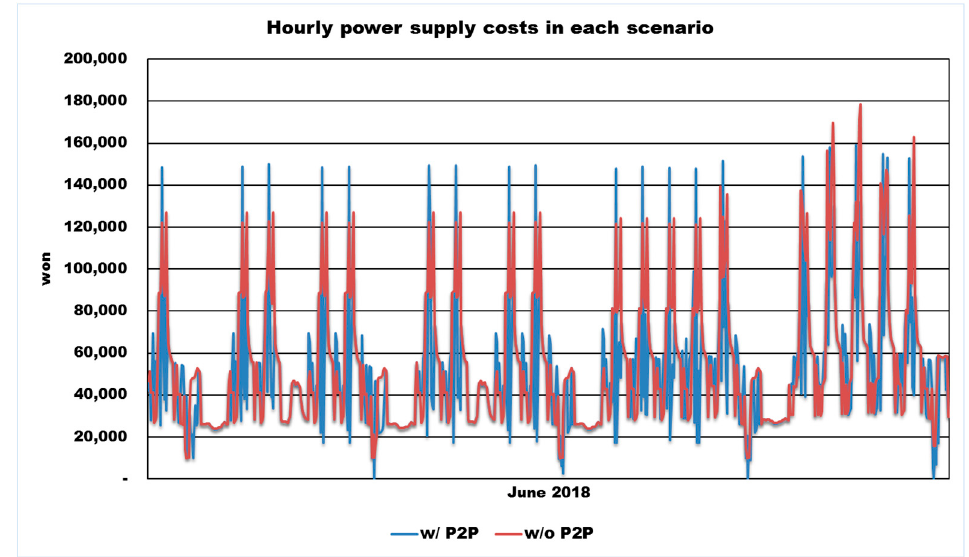
Figure 8. Comparison of hourly power supply costs in each scenario.